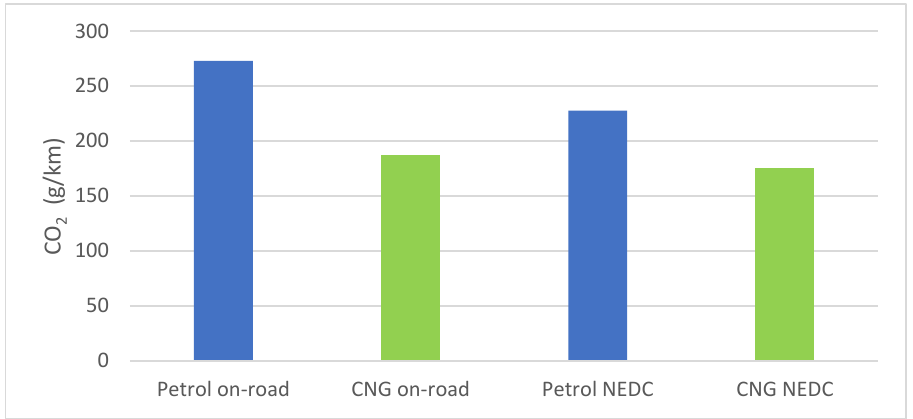
Figure 19. Comparison of CO 2 emission between vehicles fueled with petrol and CNG in the on-road and NEDC tests.